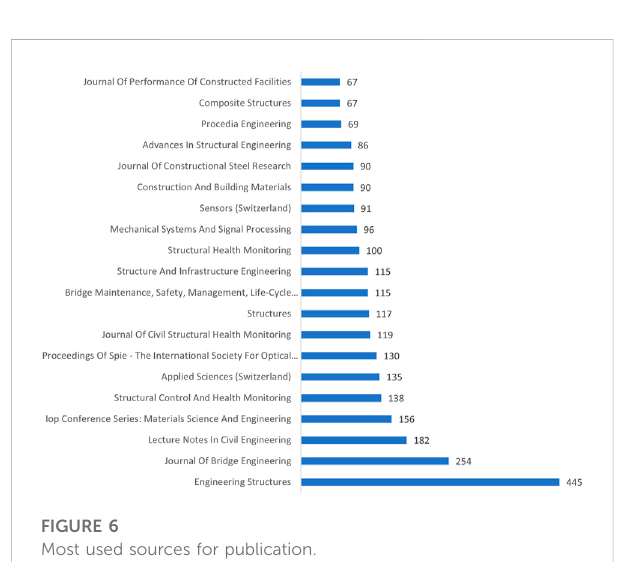
FIGURE 5 Keyword occurrence.